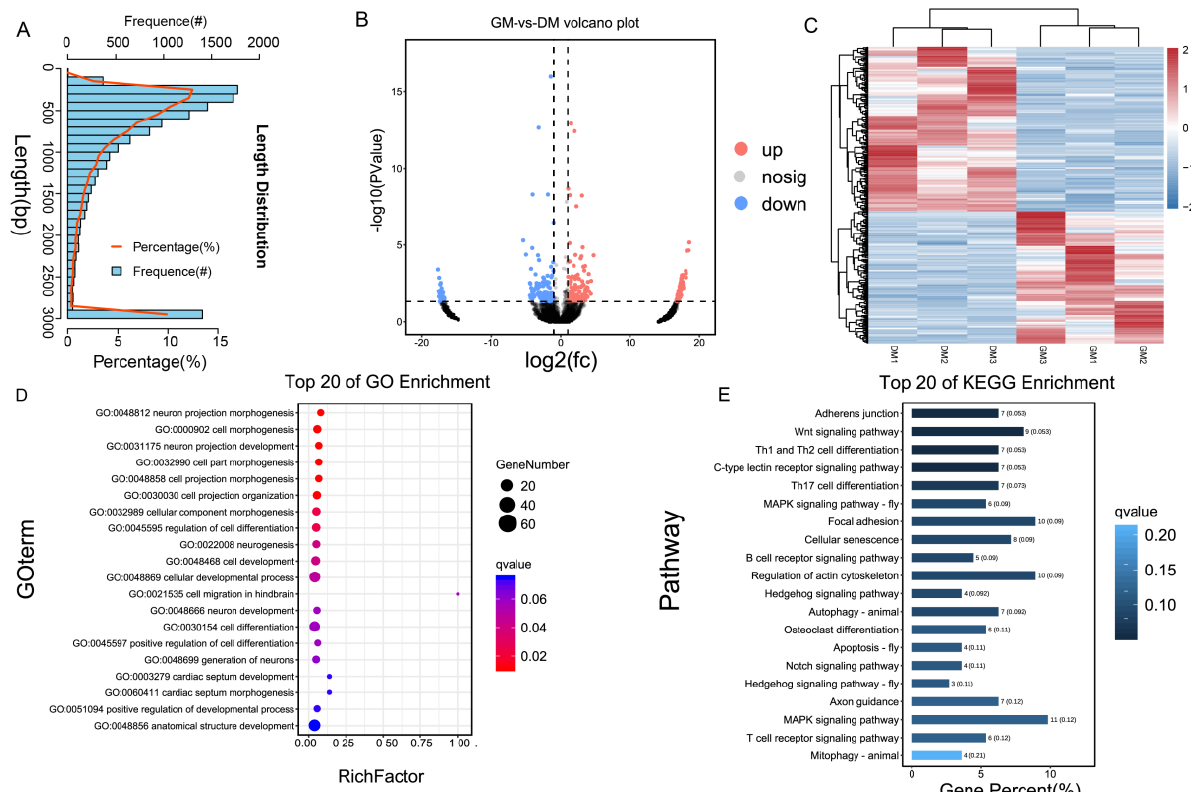
Figure 1. Overview of circular RNA sequencing. ( A ) circRNA length distribution in GM relative to DM. ( B , C ) Volcano plot ( B ) and heatmap ( C ) of differentially expressed circRNA between proliferation relative to differentiation in chicken myoblasts. ( D , E ). GO functions ( D ) and KEGG pathways. ( E ) Analysis of the parental genes of differentially expressed circRNAs.